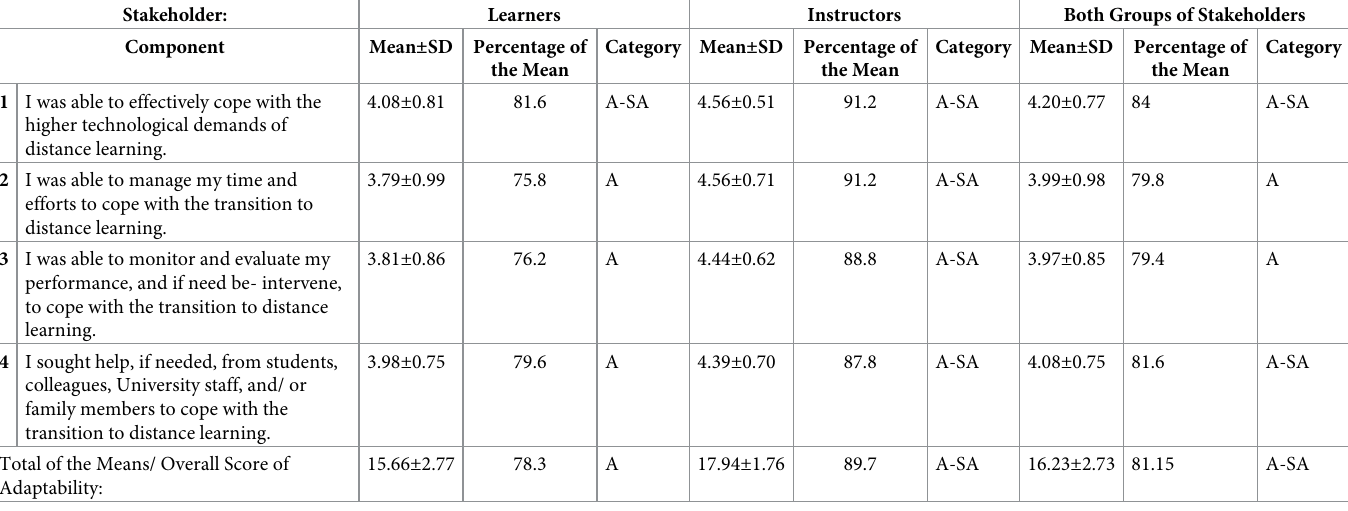
Table 1. Output of descriptive quantitative